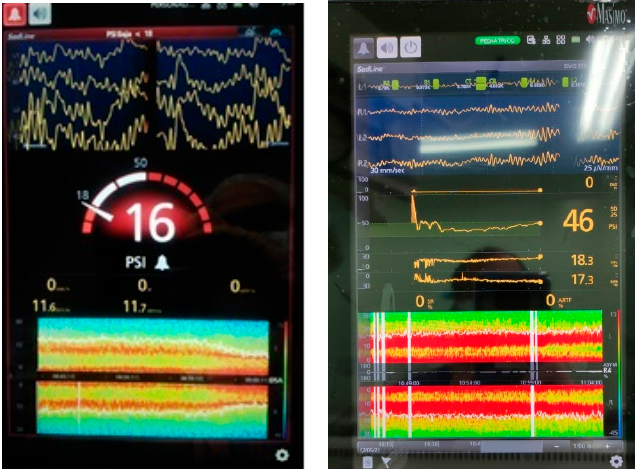
Figure 1. Up Left: Raw EEG and spectrogram from a 45-year-old patient receiving a typical Propofol anesthesia. Down at the end of the screen, observe the effect of adding Sevoflurane. Right: A 10-year-old child’s raw EEG and spectrogram. The global power and the alfa band (7–12 Hz) is much intense than in adults. (Sedline Monitor).